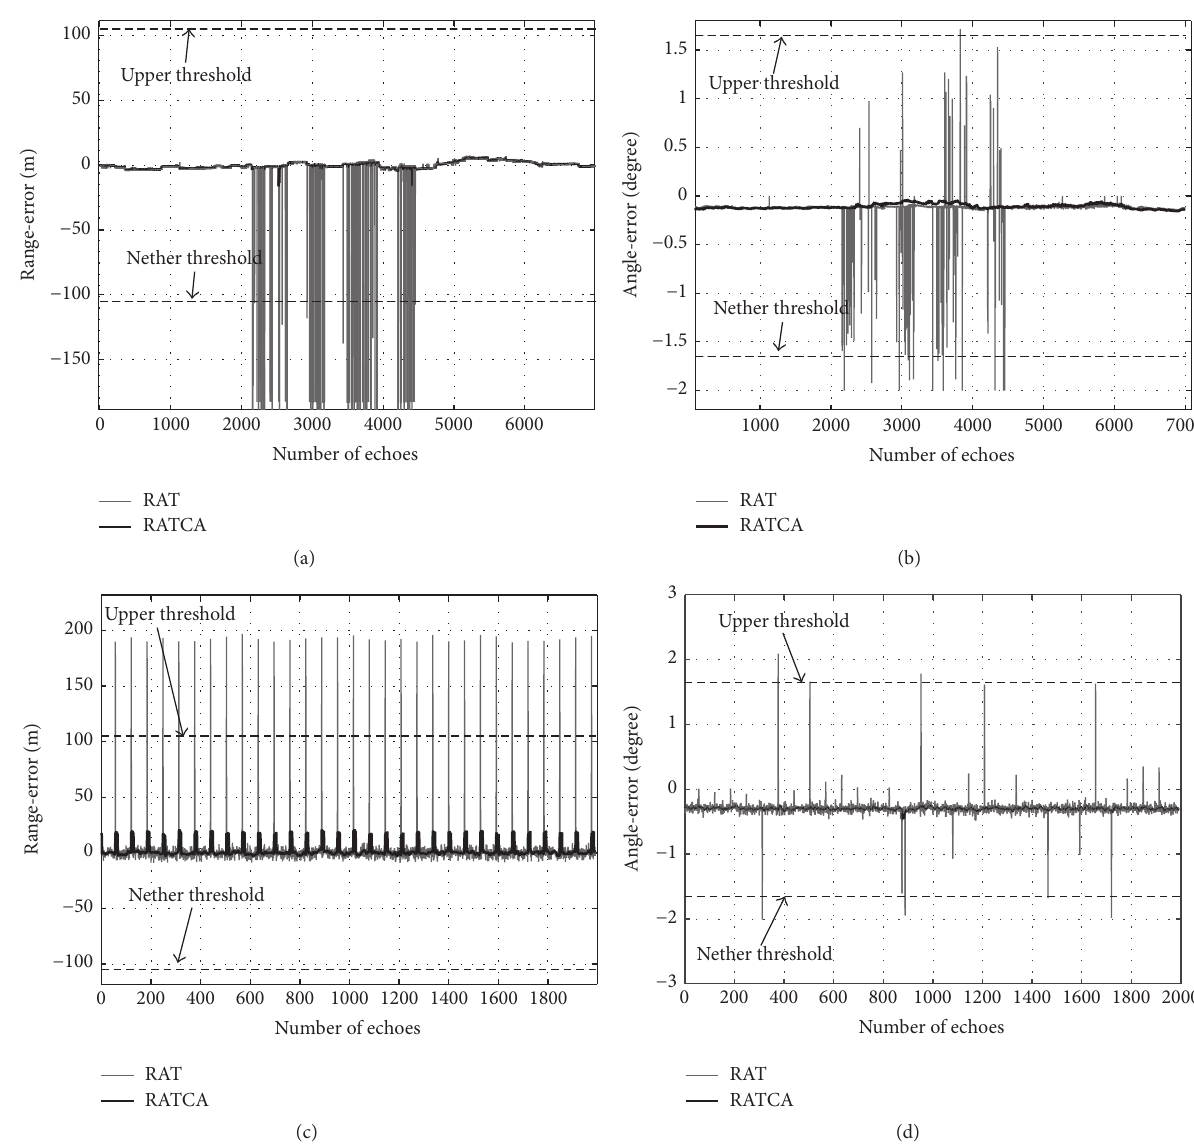
Figure 13: Tracking performances of the RAT and RATCA method in extreme condition. (a) Range estimations in RAT and RATCA methods with echo loss. (b) Azimuth estimations in RAT and RATCA methods with echo loss. (c) Range estimations in RAT and RATCA methods with jamming. (d) Azimuth estimations in RAT and RATCA methods with